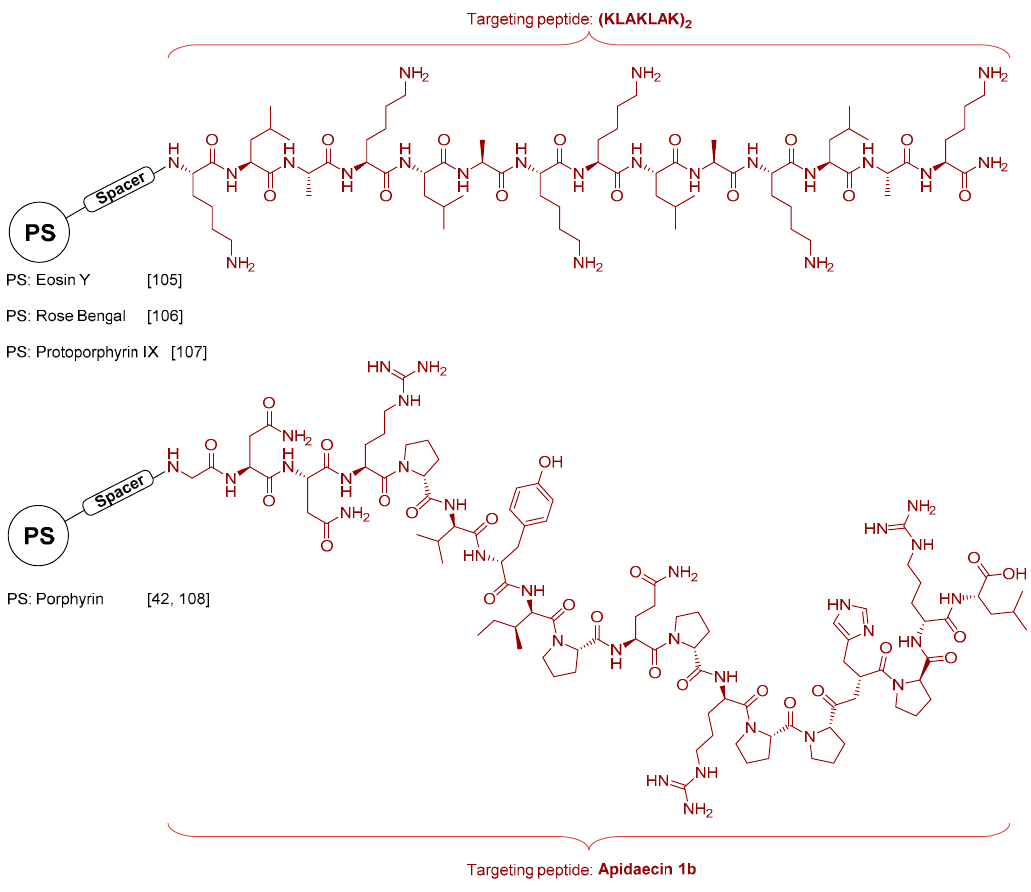
Figure 7. Examples of aPDT probes based on the AMP sequences (KLAKLAK) 2 and Apidaecin 1b conjugated to di ff erent photosensitizing